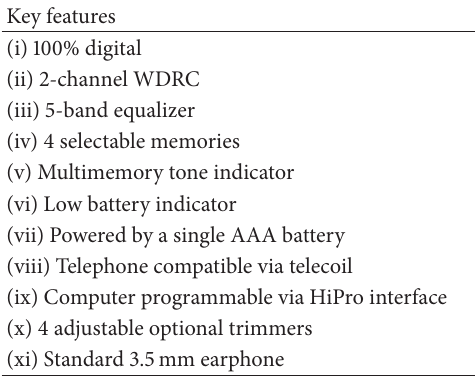
Table 2: PDN-01B